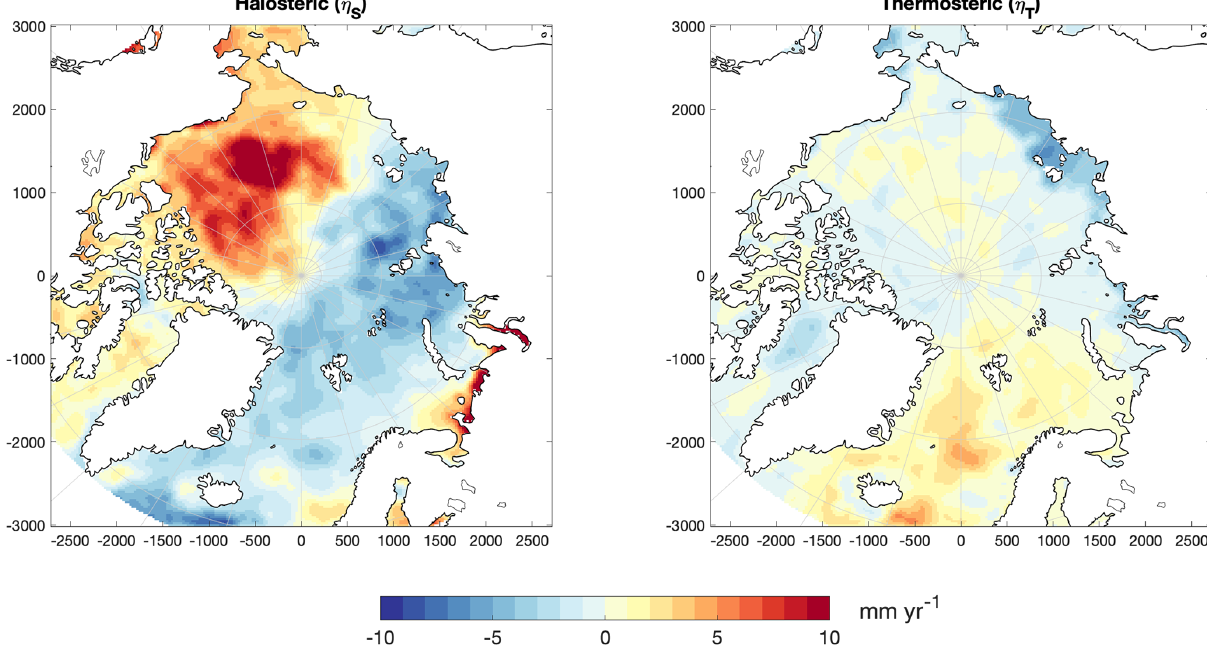
Figure 4. Halosteric and thermosteric sea level trend [mmyr − 1 ] from 1995–2015 derived from the DTU steric sea level product (Ludwigsen and Andersen,